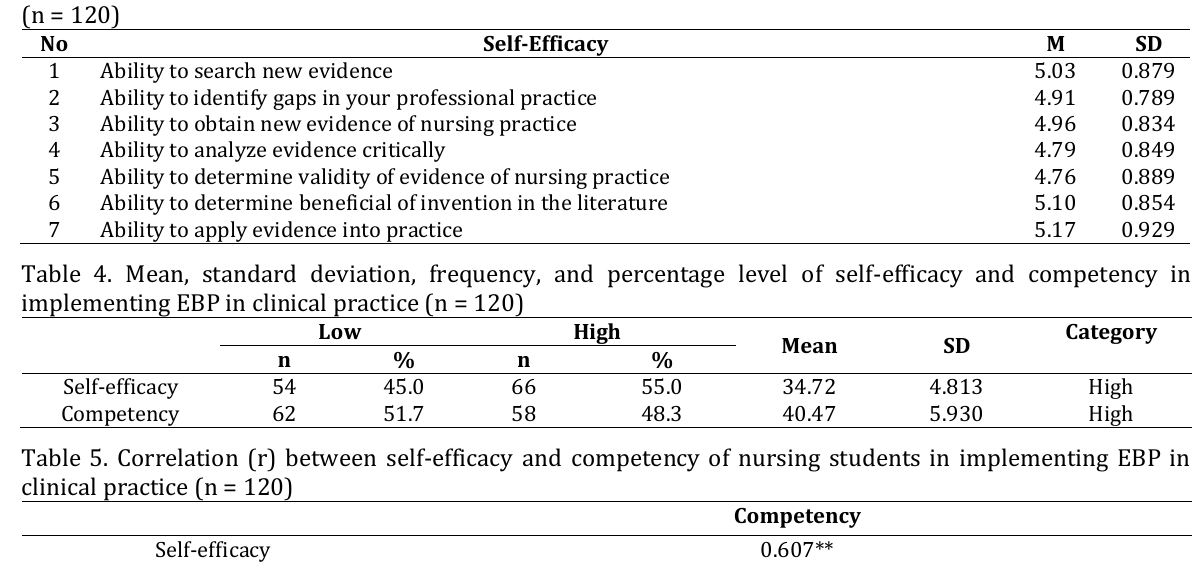
**. Correlation is significant at the 0.01 level